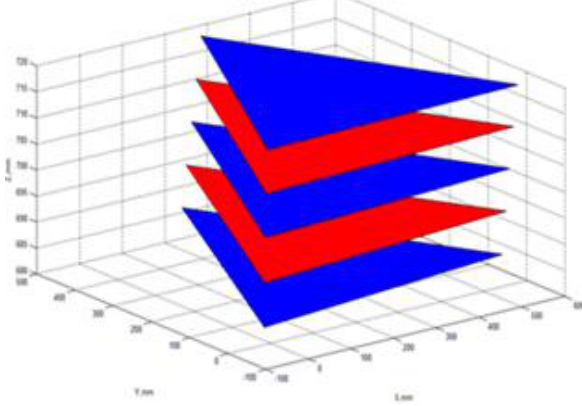
Figure 4. The diagram of location of the working body's upper platform The initial data is the main vector of the reaction force  RRR  applied at the point O and a vector of a 1 YZ  couple of forces R M resulting from the dynamic analysis of the working body under the action of maximum wind speed of 15-20 m/s and with the inertia forces taken into account. It should be noted that the force R is located (Figure 5) in the plane Q, and the moment of couple  M is directed perpendicularly to the plane Q which R coincides with the moving plane O Y Z . Thus, with a 1 1 1 given wind direction, the values R and R M are known. In addition to these forces, the unknown